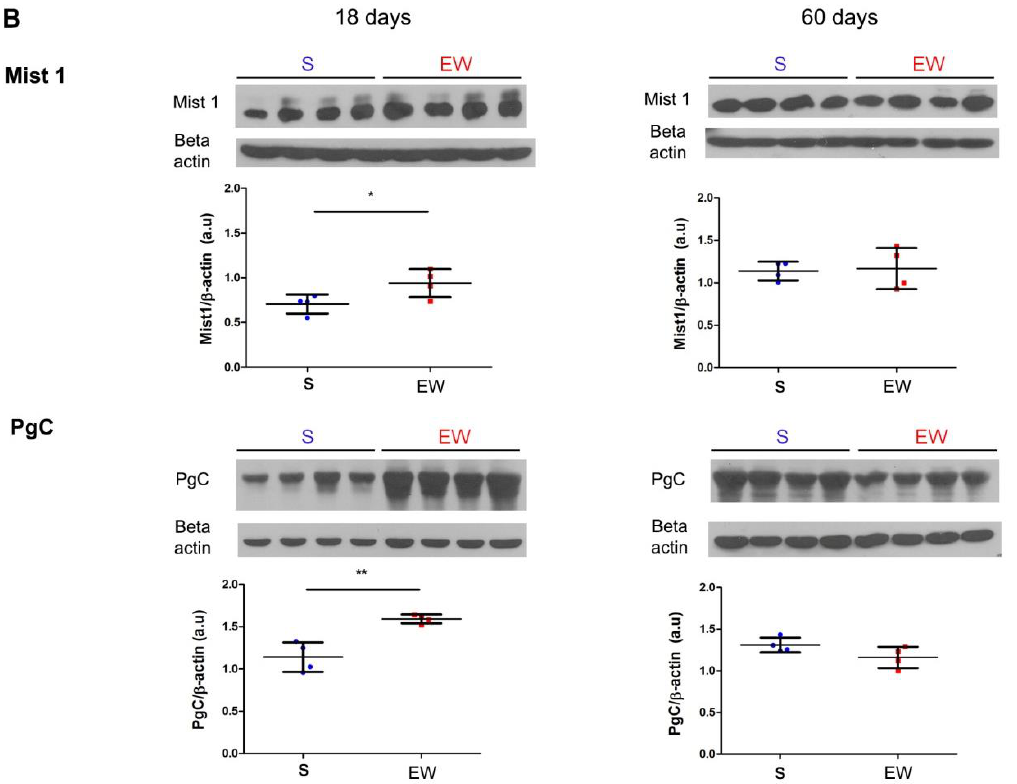
Figure 5. Early weaning alters the expression of regulatory genes and protein levels in zymogenic cells in the rat gastric mucosa. ( A ) Expression of Bhlha15 , Gif , Pga5 , Pgc was compared in gastric mucosa of S and EW rats at 18 and 60 days and levels are indicated as fold induction of internal control ( Actb ). Biological replicates: n = 3–10 animals. Technical replicates: n = 2–3. ( B ) tissue lysates from gastric mucosa were used to detect the transcription factor Mist1 (22 kDa) and pepsinogen C (42 kDa) at 18, and 60 days. Protein levels were determined by integrate optical densitometry (arbitrary units) after immunoblots and compared to the internal control protein ( β -actin, 42 kDa). Individual results are represented for S (blue) and EW rats (red) and means ± SD is indicated in each group and age. After unpaired Student t test between groups / age: *** p < 0.001; * p < 0.05, ** p < 0.01.